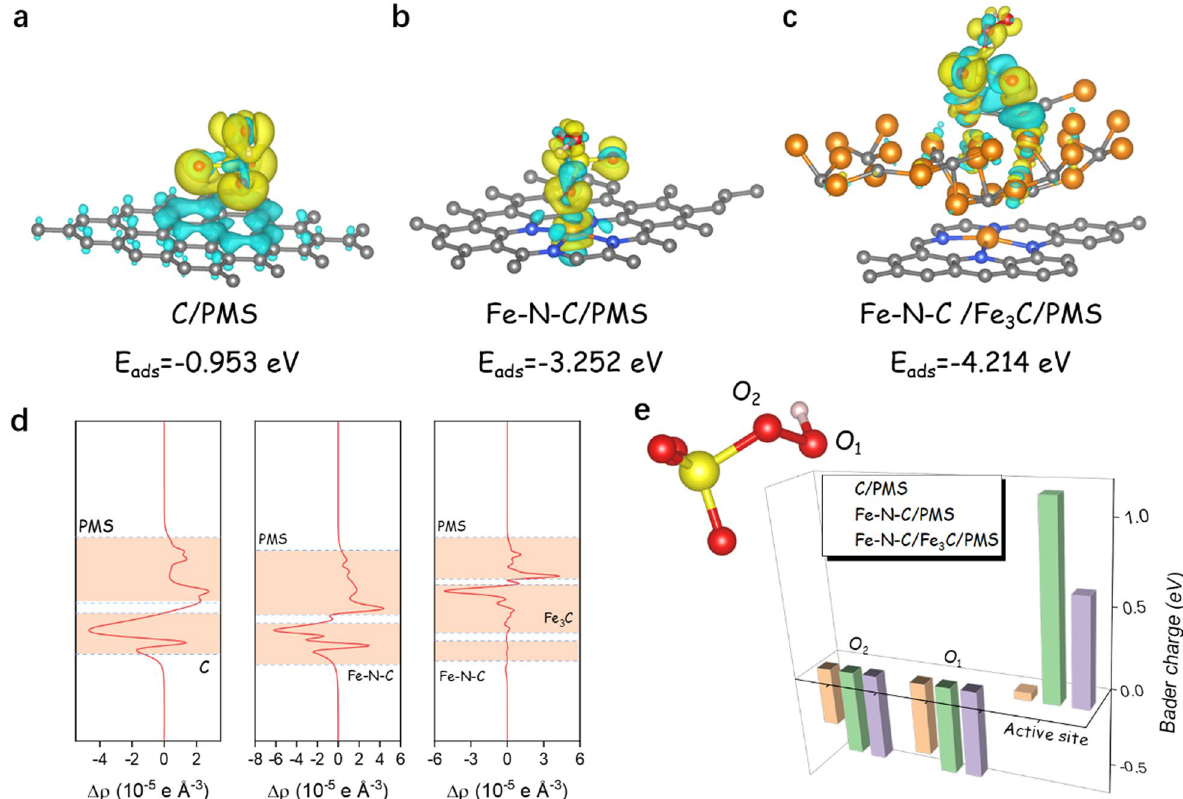
Fig. 5 Adsorption energies and the corresponding three-dimensional charge density difference calculated by DFT with different structures: ( a ) C/ PMS, ( b ) Fe–N–C/PMS and ( c ) Fe–N–C/Fe 3 C/PMS. d Profile of the planar averaged charge density difference as a function of the position in the z direction. e Charge variation of O atoms and active sites in different structures by using the Bader